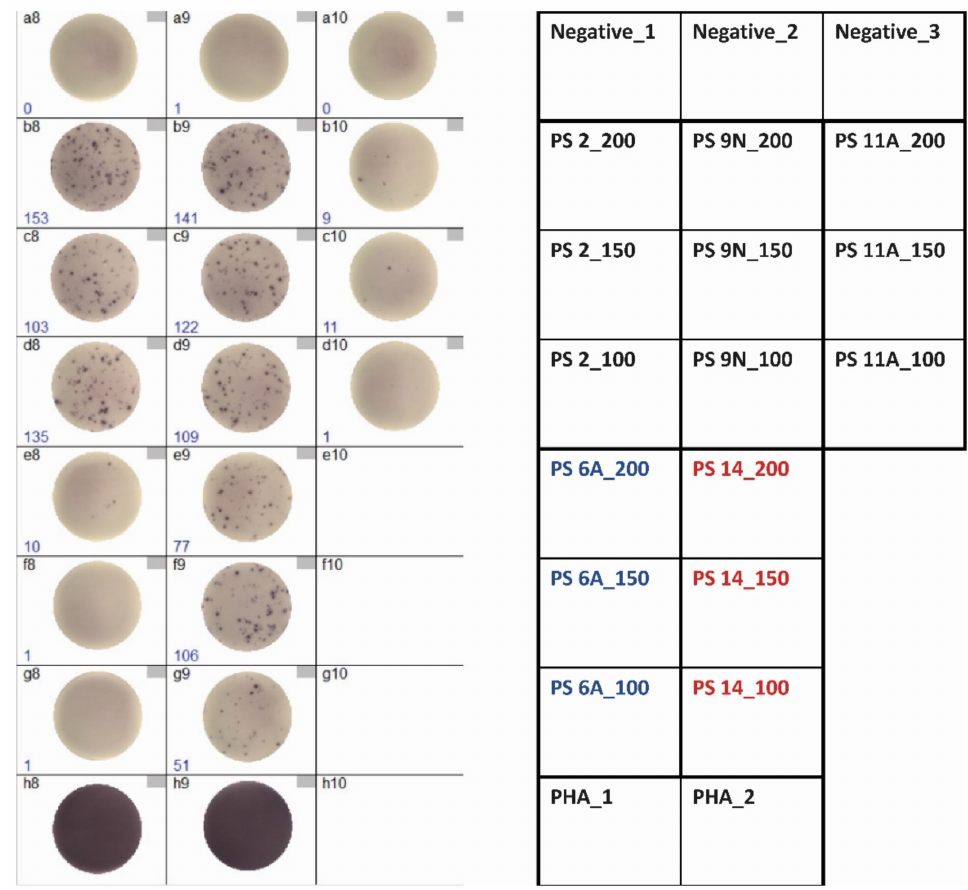
Figure 2. Interferon- γ ELISpot results (200,000 PBMC/well) in one female, 49-year-old kidney transplant recipient at month 12. The patient had received vaccination with Prevenar 13 and Pneumovax 23 12 months and 6 months prior to bleeding, respectively. Each serotype of the pneu- mococcal polysaccharides (PS) was used at three concentrations (100, 150, and 200 µ g/mL). The left panel shows the ELISpot results, the right panel the plate layout. Confluent spots filling the entire well, as shown in the positive control with phytohemagglutinin (PHA), were set as